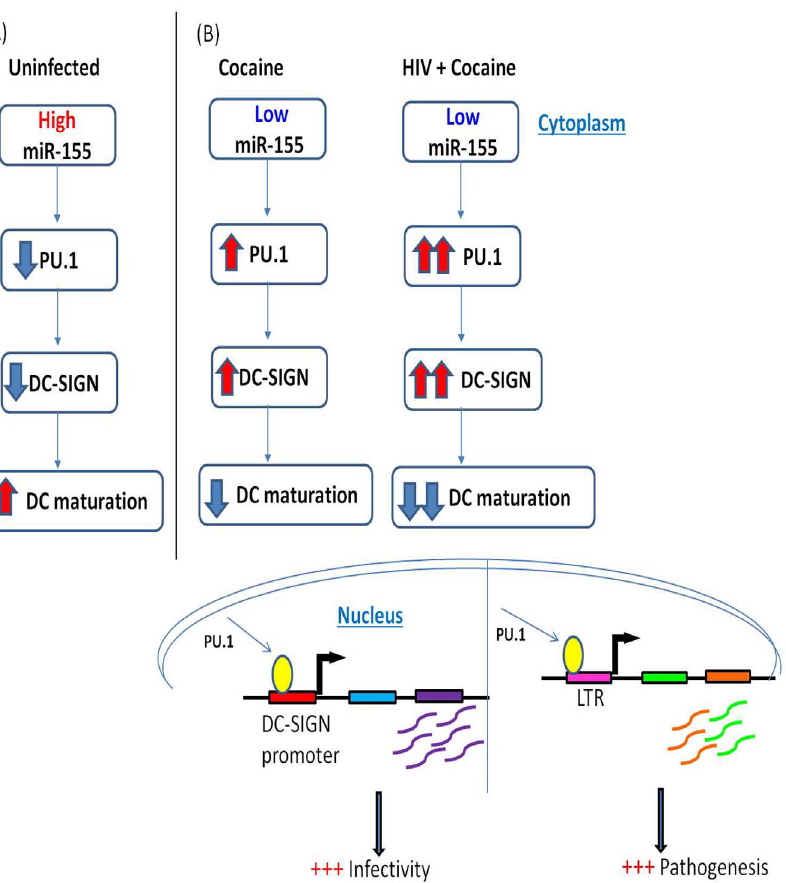
Figure 6. Overview of Cocaine-enhancement of HIV infectivity in MDC via the down-regulation of miR-155. ( A ) In absence of cocaine or HIV miR155 targets DC-SIGN and PU.1, reducing the expression post-transcriptionally. Lowered PU.1 and DC-SIGN expression is observed in mature DCs. ( B ) In the presence of Cocaine or HIV alone miR-155 levels are reduced resulting in elevated PU.1 and DC-SIGN expression. This phenotype is evident in immature DCs (iDCs). Together HIV and cocaine, synergize to dramatically lower miR-155 resulting in elevated levels of the transcription factor Pu.1. In turn, Pu.1 binds sites within the DC-SIGN promoter as well as the HIV LTR and promotes transcription. The resulting elevated DC-SIGN expression in DCs lead to maintenance an immature DC phenotype and thus increased HIV infectivity. By binding NF- k B sites within the LTR, PU.1 increases viral transcription and pathogenesis.